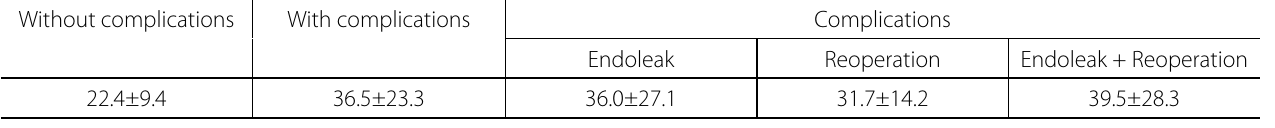
M=male; AAA=abdominal aortic aneurysms; CIA= aneurysms of the common iliac arteries; SAH=systemic arterial hypertension; HD=heart disease; C=cancer; CRF=chronic renal failure; PVD=peripheral vascular disease; DM=diabetes mellitus; TB=tabagist; EX-TB= ex-tabagist; LD=liver disease; COPD=chronic obstructive pulmonary disease; R=right; L=left